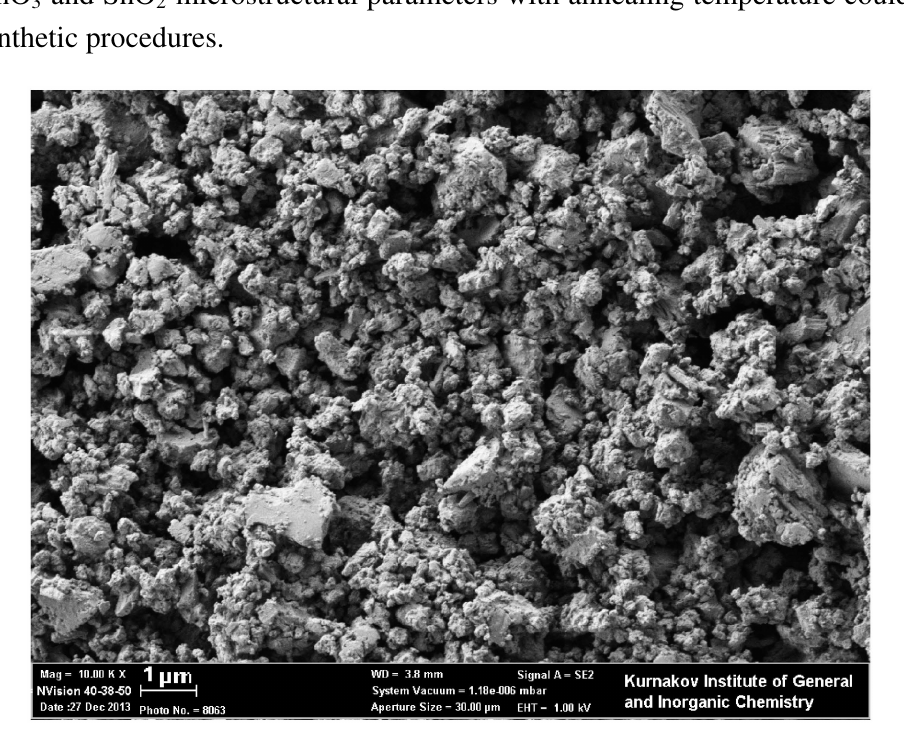
Figure 3. SEM image of BaSnO sample annealed at 275 ˝ C. 3 Table 1. Samples designation, phase composition and microstructure